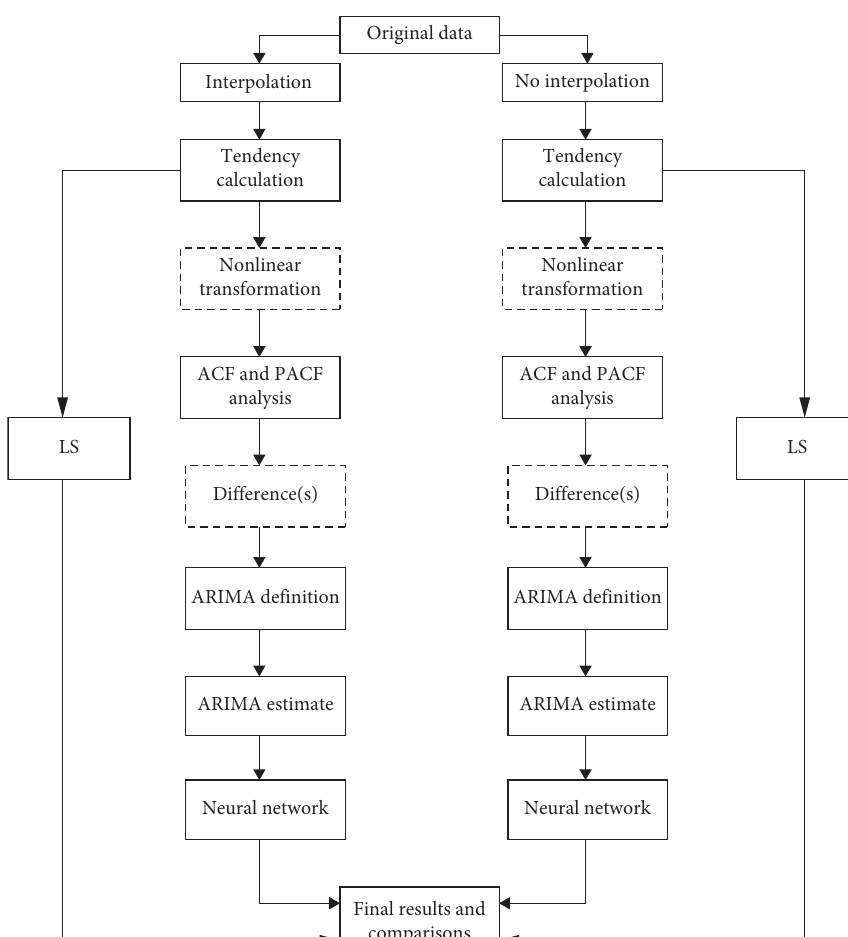
Figure 2: All the steps followed in the fitting process. Optional steps in dashed lines.